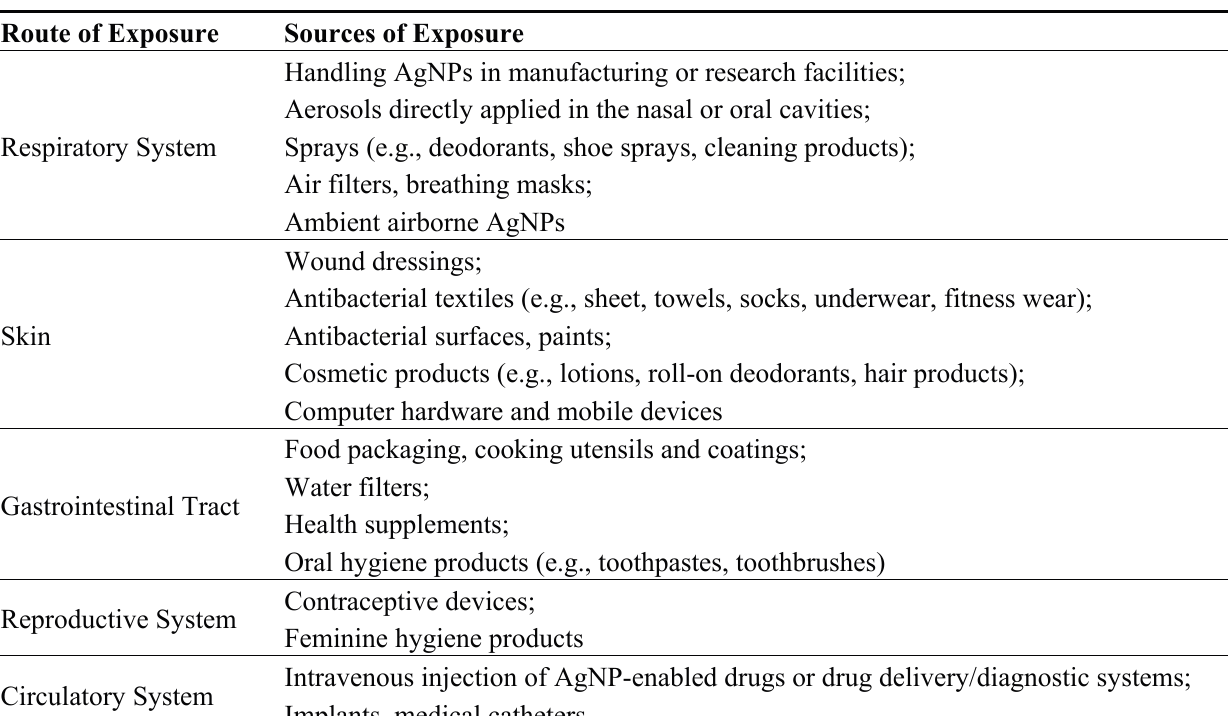
Table 1. Possible routes of human exposure to silver